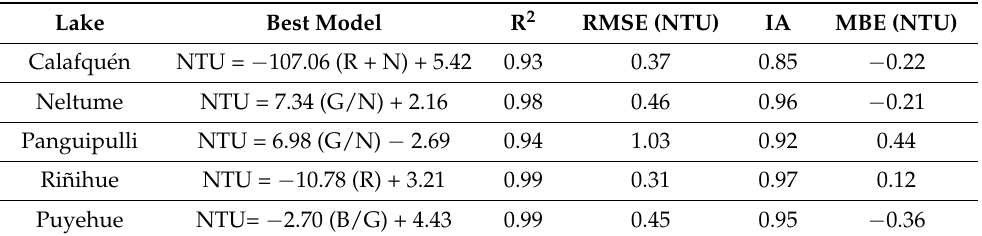
Table 5. The models of turbidity estimation and statistical indicator for each lake.